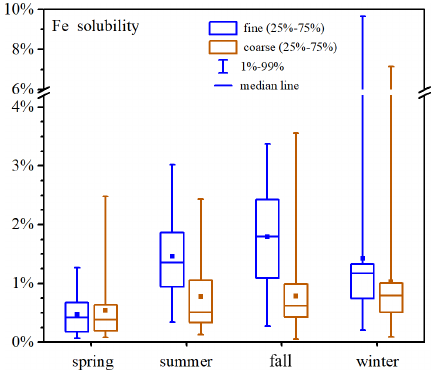
Figure 4. Seasonal variations of aerosol Fe solubility for fine and coarse particles at